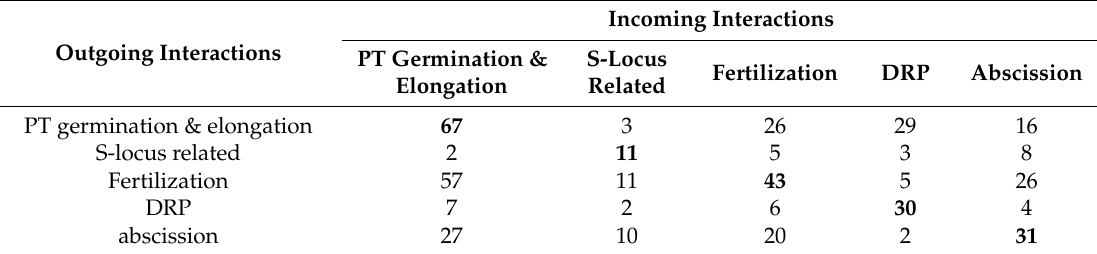
Table 1. Intra-interactome network analysis among five categories showing a number of outgoing and incoming interactions.